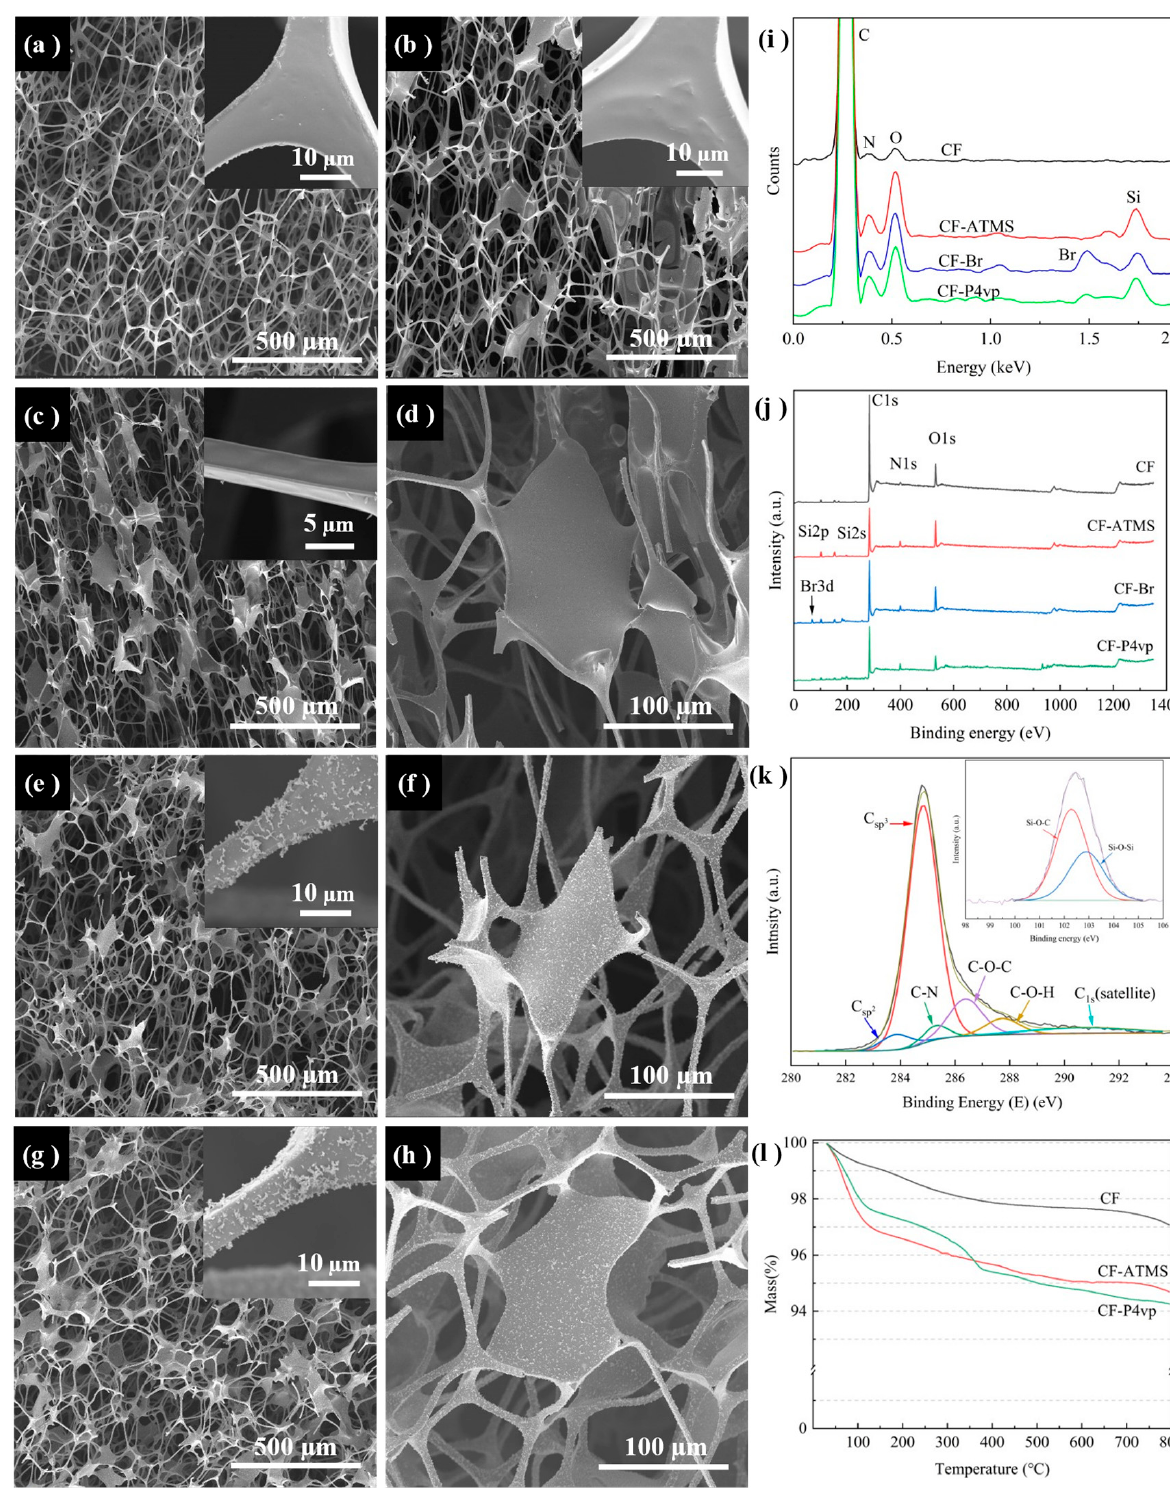
Figure 2. Characterization of the as-fabricated polymer foams: ( a – h ) SEM images of ( a ) MF, ( b ) LLS- MF, ( c , d ) CF, ( e , f ) CF-ATMS, and ( g , h ) CF-P4vp (pH-responsive CF); ( i , j ) EDS and XPS spectra of CF, CF-ATMS, CF-Br, and CF-P4vp; ( k ) XPS spectra of C 1s peak of CF and Si 2p peak of CF-ATMS (inset); ( l ) TGA curve of CF, CF-ATMS, and CF-P4vp under nitrogen.